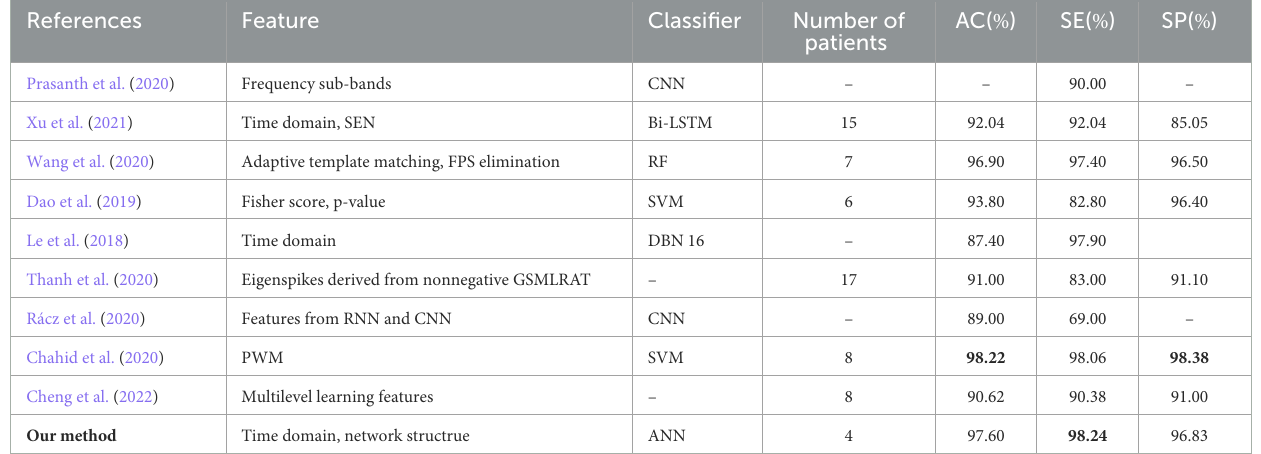
TABLE 4 Performance comparison of recent automatic spike detection